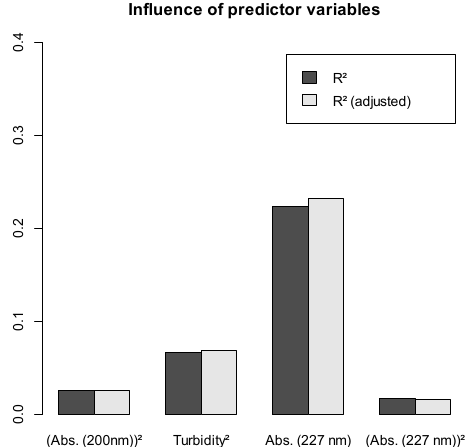
Figure 10. Influence of predictor variables: total AOX.